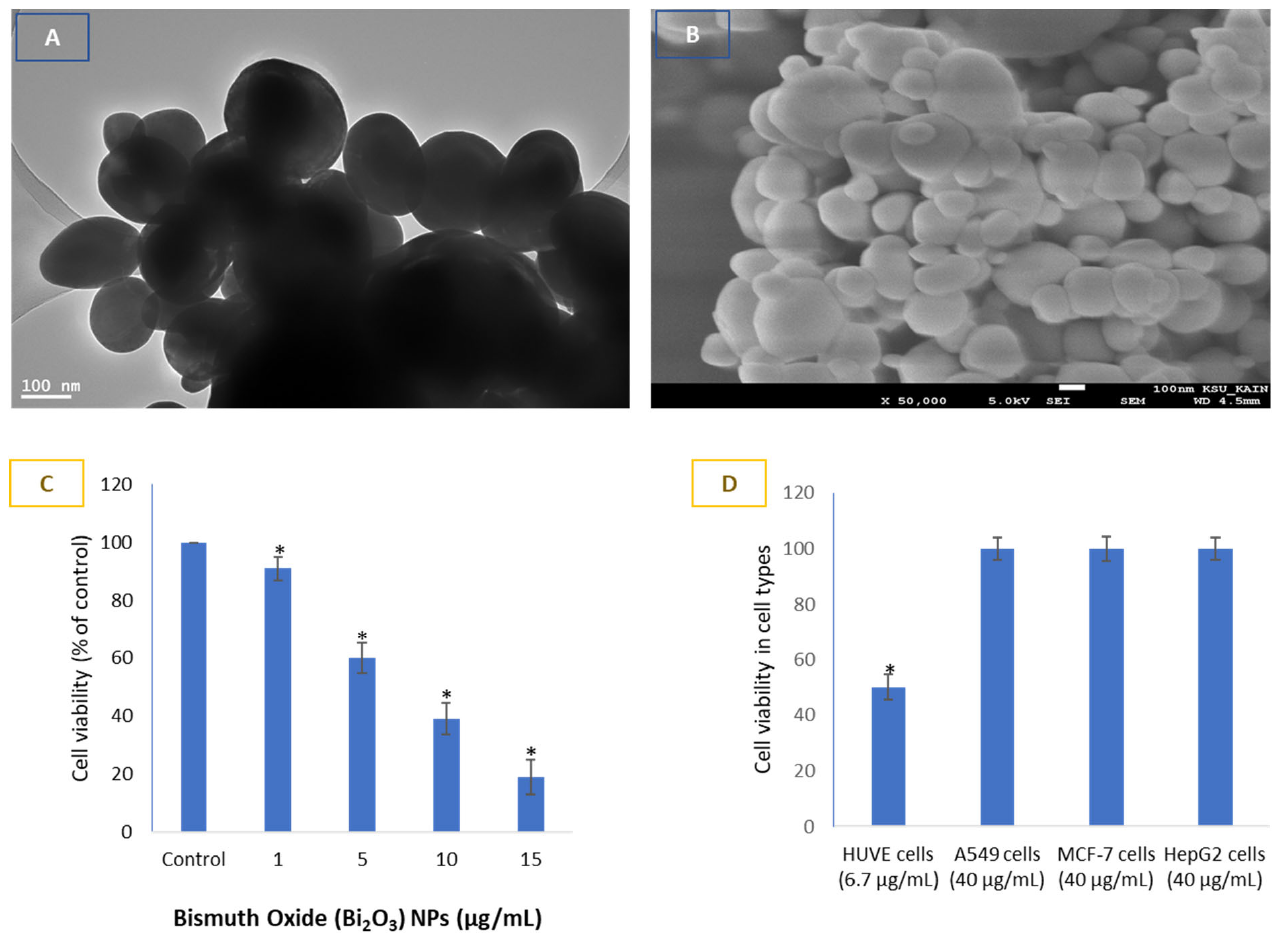
Figure 1. Shapes and sizes of bismuth oxide nanoparticles (BNPs) (70 nm) and their bio-response in endothelial cells with EC50 of 6.7 µ g/mL exposed to 24 h. BNPs appear spherical in shape as evidenced by images captured by transmission electron microscopy ( A ) and scanning electron microscopy ( B ). Bar length in ( A , B ) corresponds to 100 nm. Concentration-dependent cell viability in HUVE cells ( C ). Cytotoxicity induced by BNPs in HUVE cells was compared with the cytotoxicity potential in cells of epithelial origins ( D ). Data suggest BNPs to be potently toxic in endothelial cells with an EC50 of 6.7 µ g/mL while exhibiting little sign of toxicity in epithelial cells exposed to up to 40 µ g/mL for 24 h. The epithelial cells were chosen because of their easy availability in our lab. The numerical value in ‘ µ g’ given for each cell type represents the concentration in µ g/mL. EC50, defined as the concentration of the substance at which the response is half of its maximal response, was calculated using an online calculator (https://www.aatbio.com/tools/ic50-calculator) (accessed on 18 February 2023) provided by AAT Bioquest, Inc. (San Francisco, CA 94085, USA) using a ‘three in triplicate. * Statistically significant difference compared to the controls ( p <